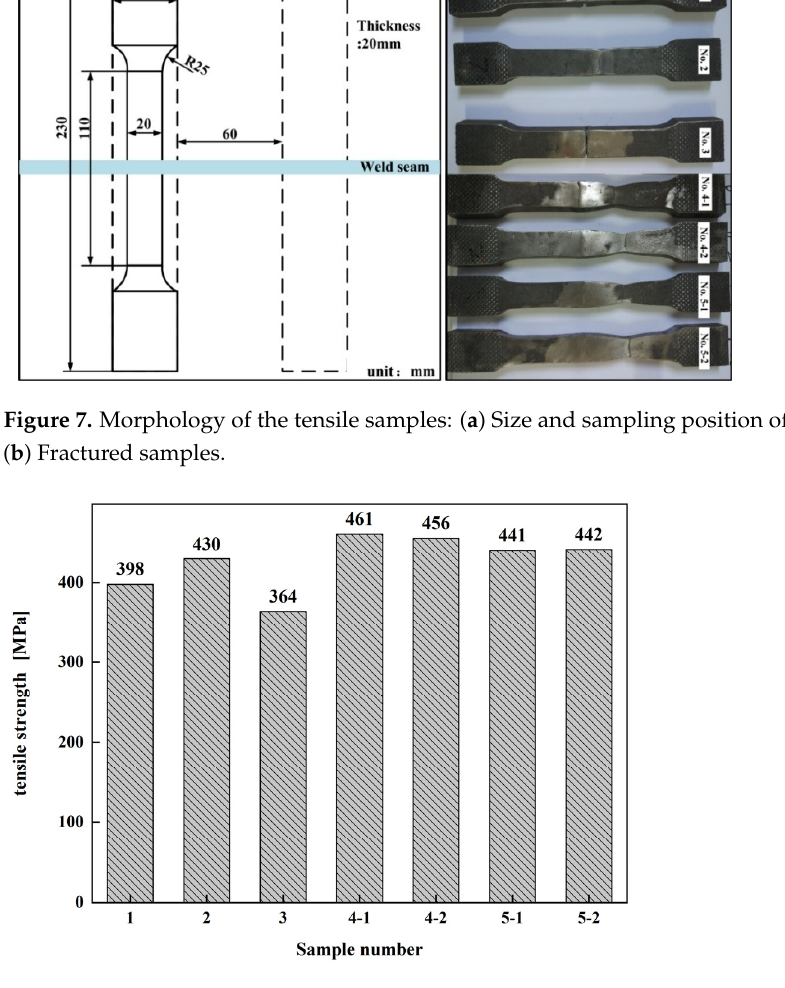
Figure 8. Tensile test results of the average tensile strength.